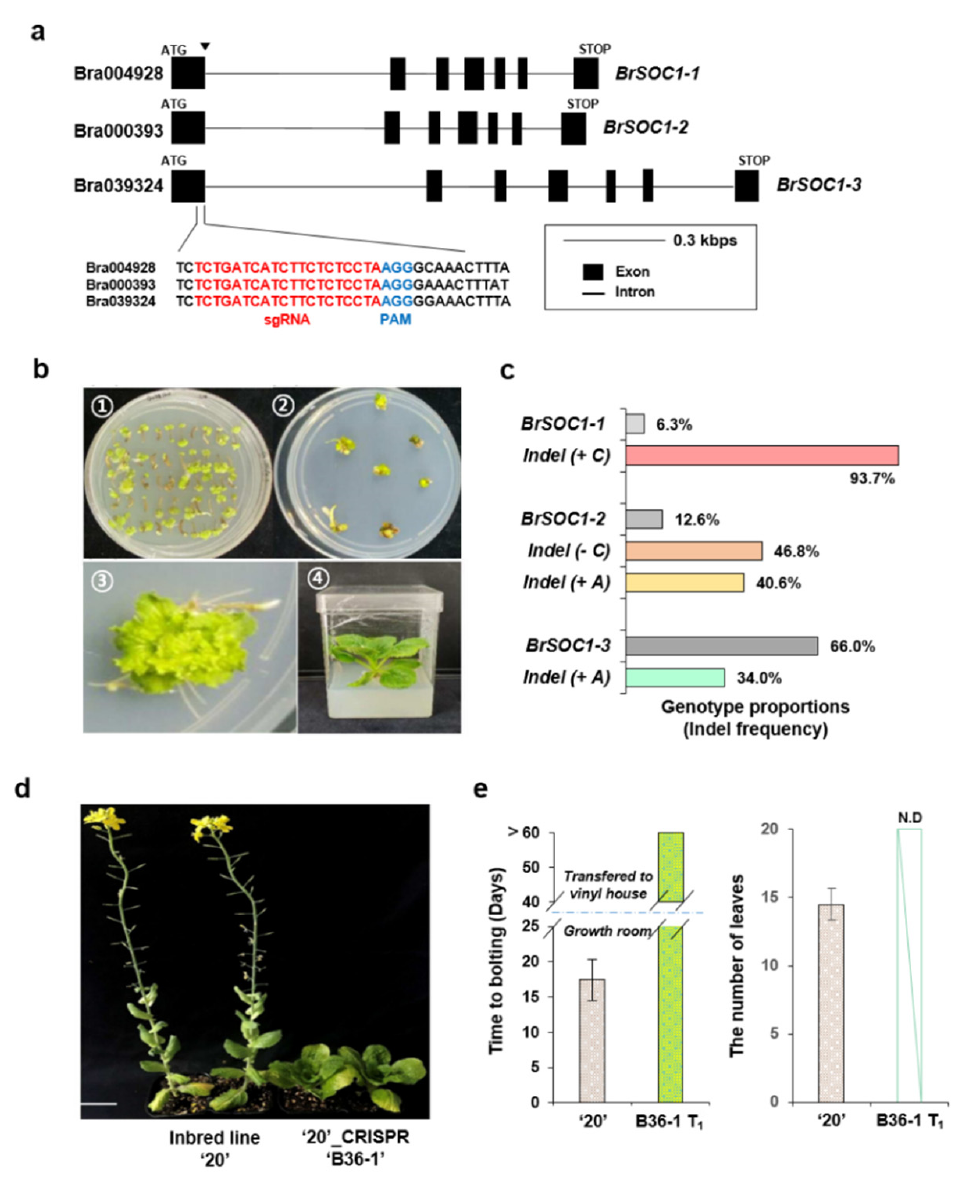
Figure 6. Analysis of BrSOC1- encoding genes edited using CRISPR/Cas9 in Agrobacterium tumefaciens - mediated Chinese cabbage transformation and regeneration. ( a ) Generation of single-guide RNA (sgRNA) from exon 1 of BrSOC1s genomic sequence. ( b ) Chinese cabbage transformation and regeneration process. The pictures show the following: 1 (cid:13) culture in a selection medium after co- cultivation of Chinese cabbage and Agrobacterium tumefaciens ; 2 (cid:13) shoot regeneration; 3 (cid:13) magnified picture of shoot regeneration; and 4 (cid:13) plant with root regeneration. ( c ) Analysis of T 0 plant by next-generation sequencing (NGS). Percentage indicates proportion between wild-type line “20” and insertion/deletion (indel) variants (#) of BrSOC1s genome-edited plants. ( d ) Representative plants illustrating the bolting phenotype of wild-type (“20” inbred line with early bolting) and genome-edited T 0 plants (B36-1 with late bolting). Scale bars = 5 cm. ( e ) Statistical analysis of the days to bolting and number of leaves in “20” and B36-1 under culture room condition for 30 days and then transferred to the vinyl house for over 30 days ( n = 20, T 0 generation, error bars = S.D.). N.D, not determined due to late bolting under vinyl house